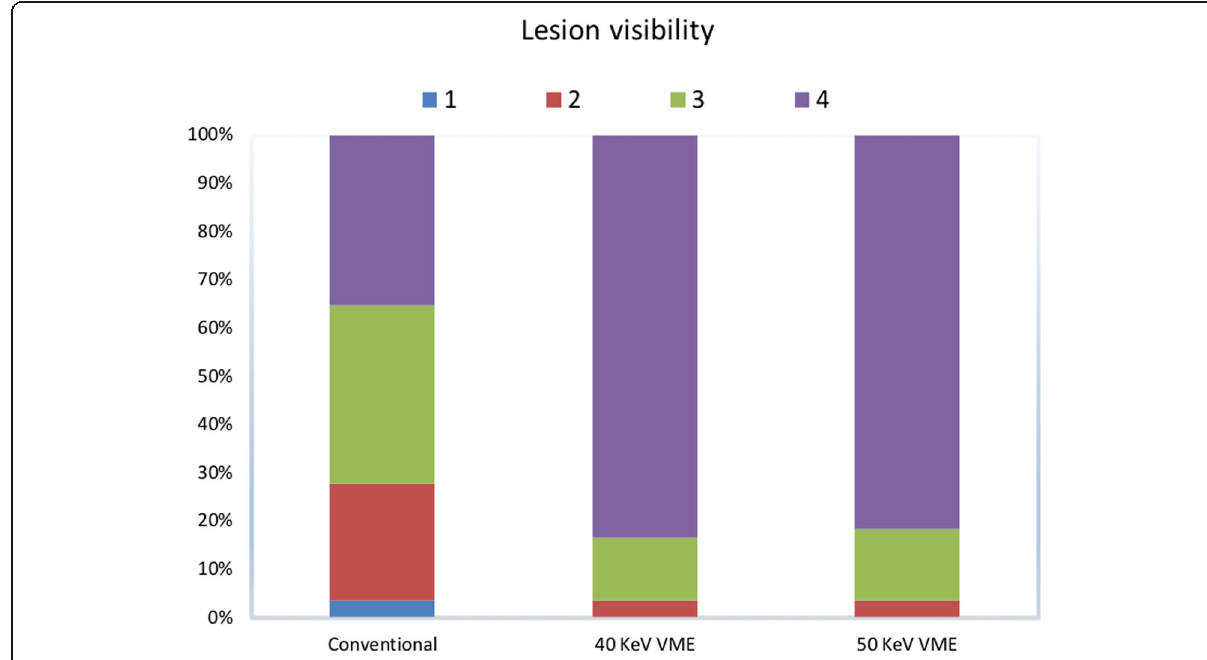
Fig. 2 Qualitative analysis of image sets (40 KeV, 50 KeV, and conventional) according to lesion